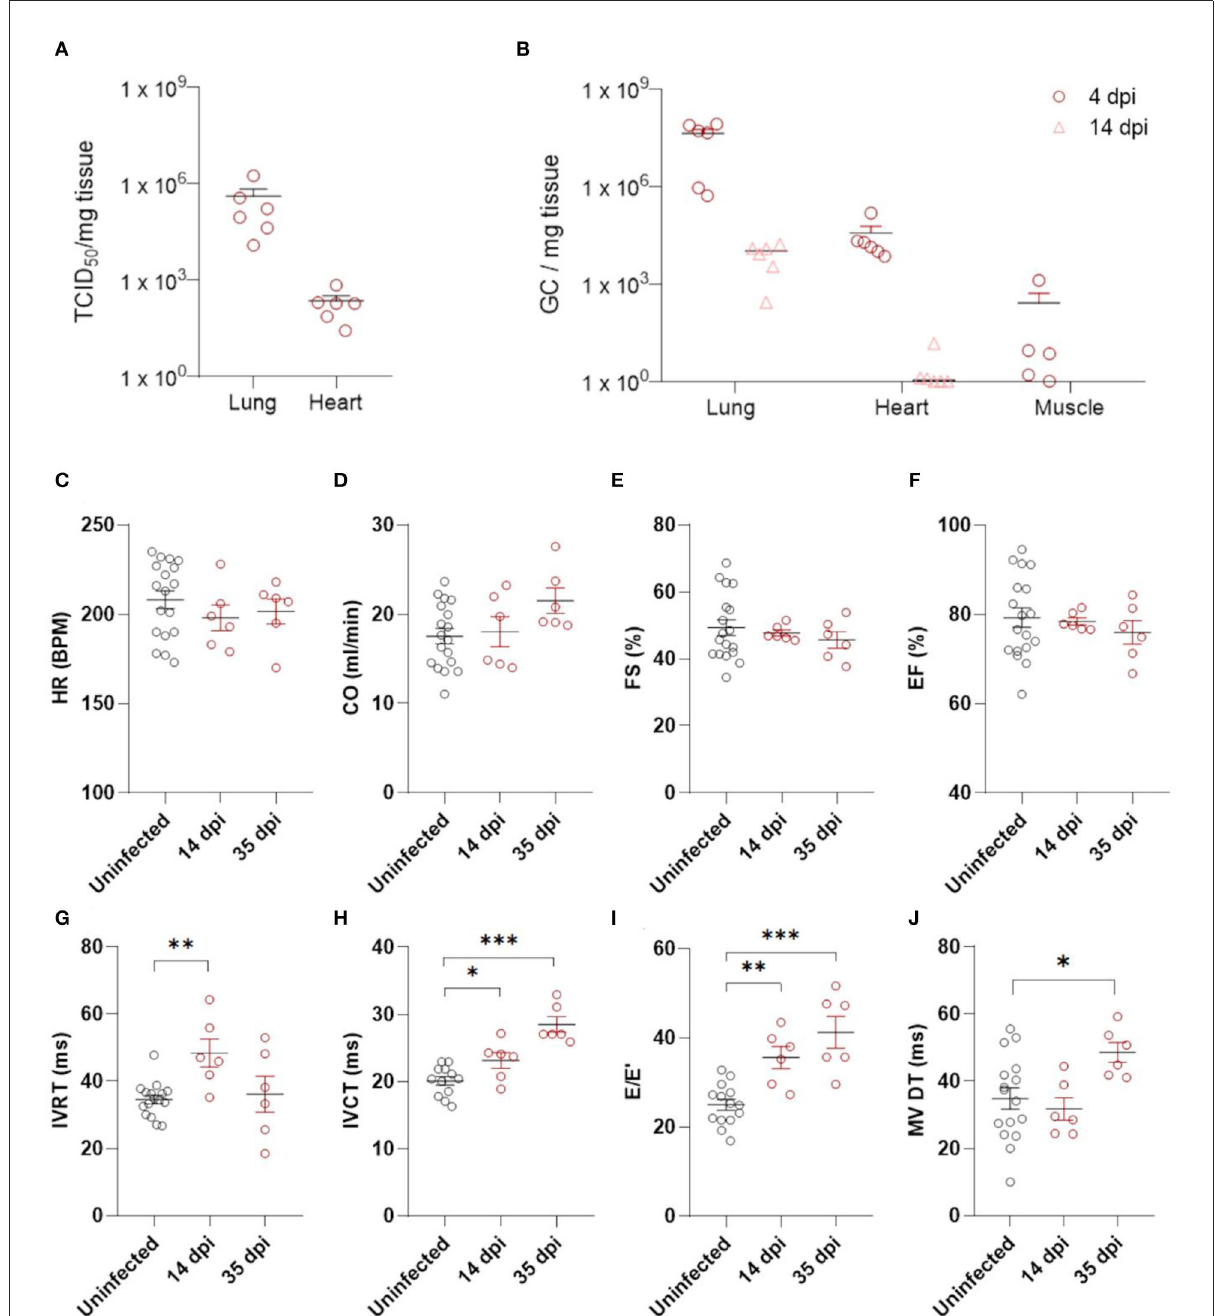
FIGURE1 Echocardiography demonstrates diastolic dysfunction in SARS-CoV-2 infected hamsters. (A) Viral loads in tissue of hamsters 4 days post infection were assessed by endpoint dilution on cell cultures and expressed as TCID 50 per mg of lung tissue. (B) Viral RNA levels were quantified by RT-qPCR in lung, heart, and muscle from infected and uninfected hamsters. (C–J) Cardiac function of 12 week old hamsters was investigated using echocardiography 2 and 5 weeks after SARS-CoV-2 infection, compared to age-matched controls. HR (C) , CO (D) , FS (E) , EF (F) , IVRT (G) , IVCT (H) , E/E ′ (I) , and MV DT (J) were analyzed. CO, cardiac output; DPI, days post Infection; E, early mitral inflow peak velocity; E ′ , early diastolic mitral annulus peak velocity; EF, ejection fraction; FS, fractional shortening; HR, heart rate; IVCT, isovolumic contraction time; IVRT, isovolumic relaxation time; MV DT, mitral valve deceleration time. Values are presented as mean ± SEM with n = 18 (uninfected) and n = 6 (SARS-CoV-2 infected hamsters). All data were analyzed using a one-way ANOVA followed by a Dunnett’s multiple comparison test with * p < 0.05, ** p < 0.01, *** p < 0.001 comparing 14 dpi and 35 dpi hamsters to uninfected